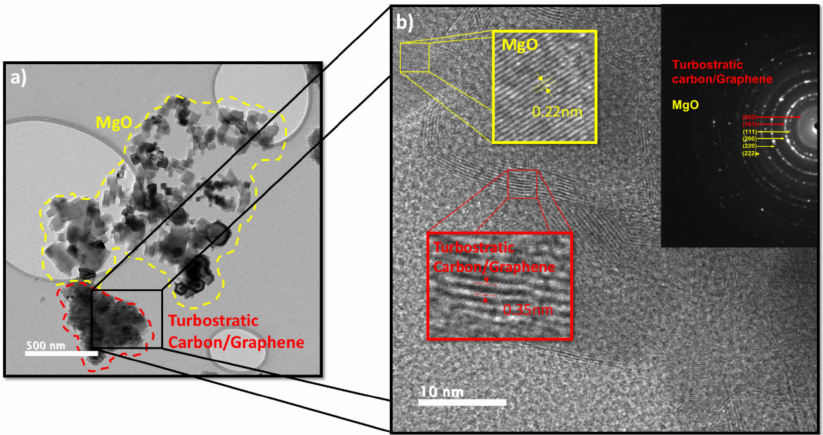
Figure 3. ( a ) TEM image ( b ) HRTEM image and SAED pattern of the raw sample obtained after the synthesis.